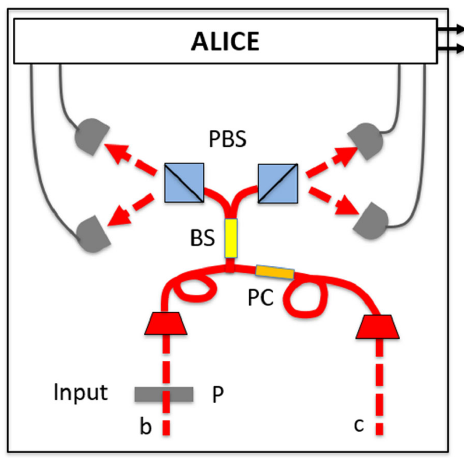
FIG. 12. Schematic representation of the apparatus to project two photons into a Bell